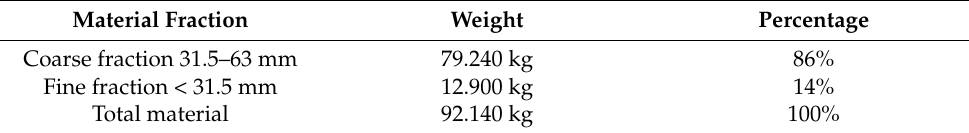
Table 3. Total weight of ballast material categorized as fine and coarse material for sample